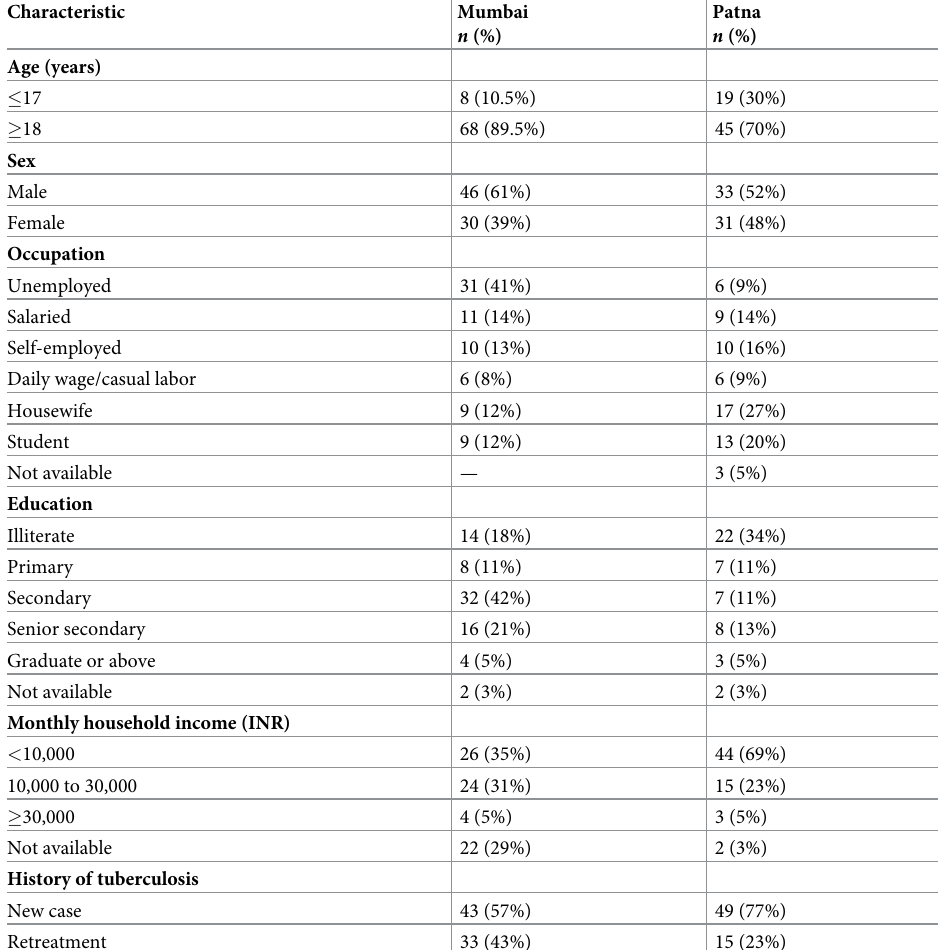
Table 1. Demographics and characteristics of the study sample. Characteristic Mumbai